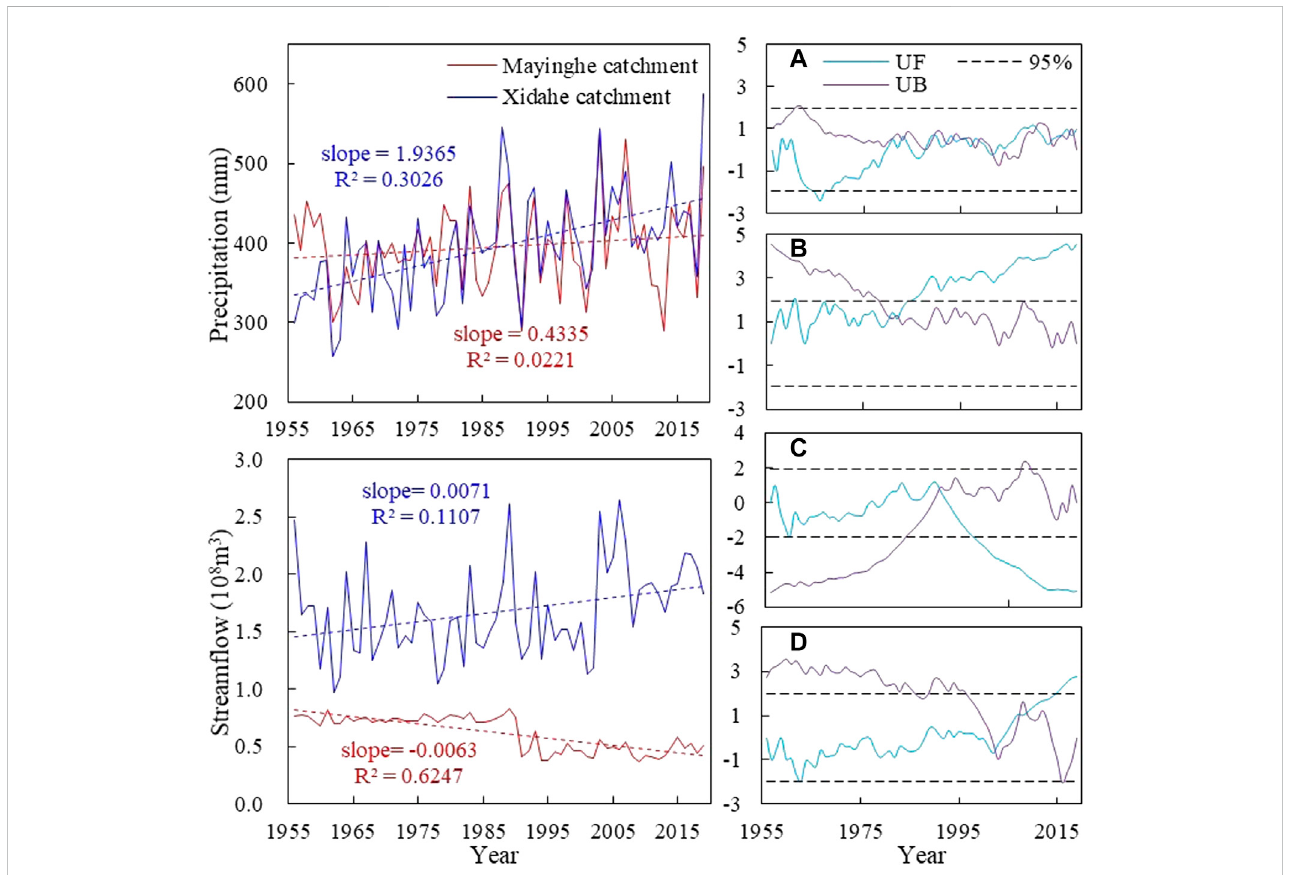
FIGURE 2 Trends of precipitation and stream fl ow (left column); M-K tests of precipitation and stream fl ow (right column): (A) precipitation M-K test of MYC; (B) precipitation M-K test of XDC; (C) stream fl ow M-K test of MYC; (D) stream fl ow M-K test of XDC. The slope is the regression coef fi cient of linear regression, which means that stream fl ow and precipitation change with